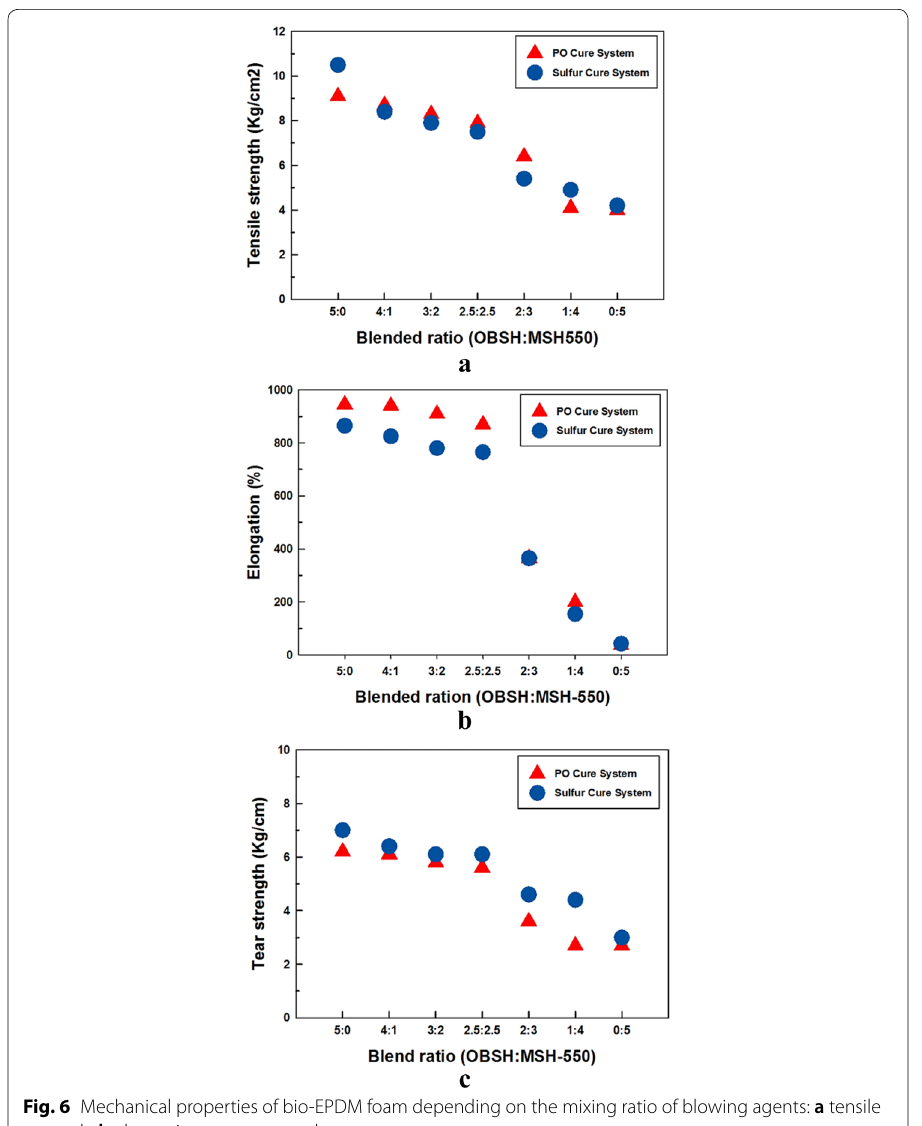
Fig. 6 Mechanical properties of bio‑EPDM foam depending on the mixing ratio of blowing agents: a tensile strength, b elongation, c tear strength